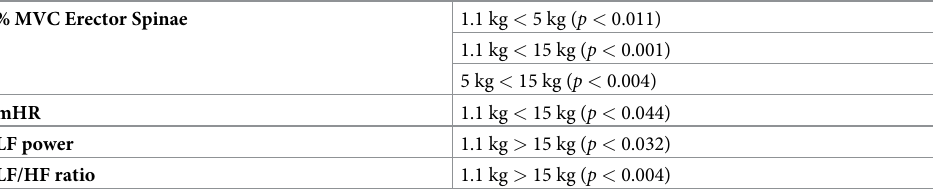
Table 6. Summary of significant contrasts where the main effects of the weight magnitude was